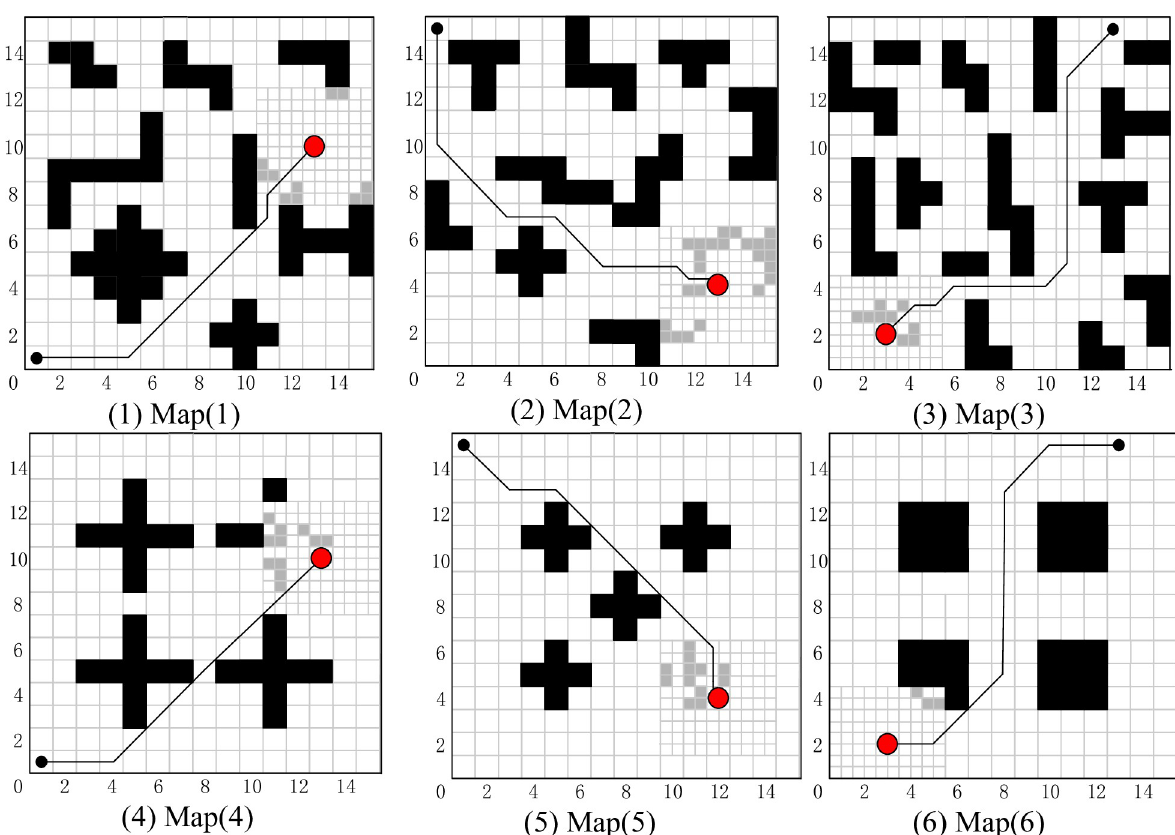
Fig 10. The optimal path in the improvement gird map using FIQL algorithm.